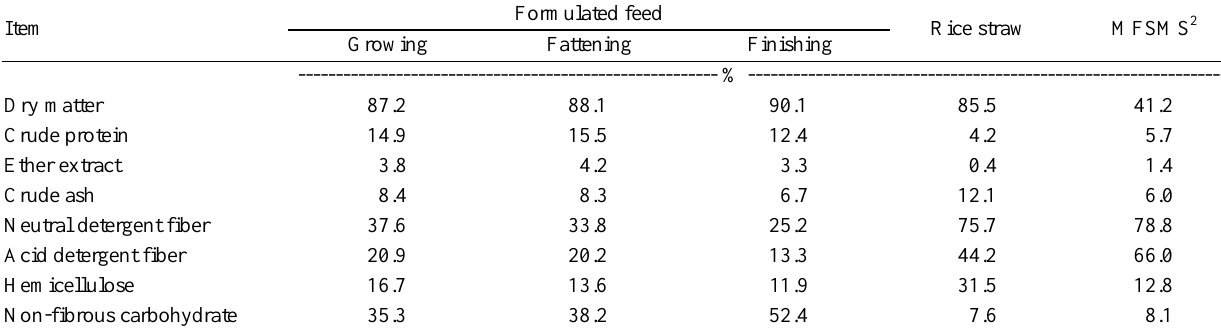
Table 1. Chemical composition of feeds fed to Hanwoo steers